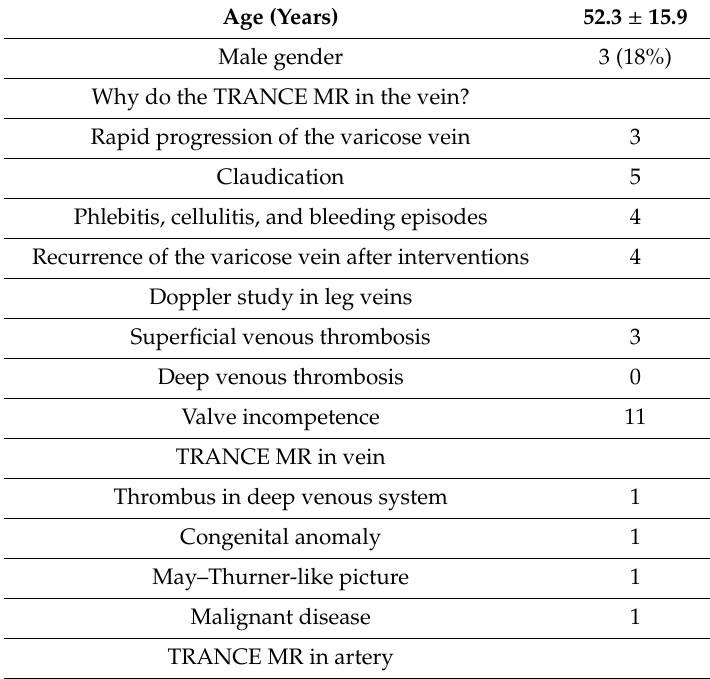
Table 4. Demographic characteristics of 16 patients with symptomatic varicose